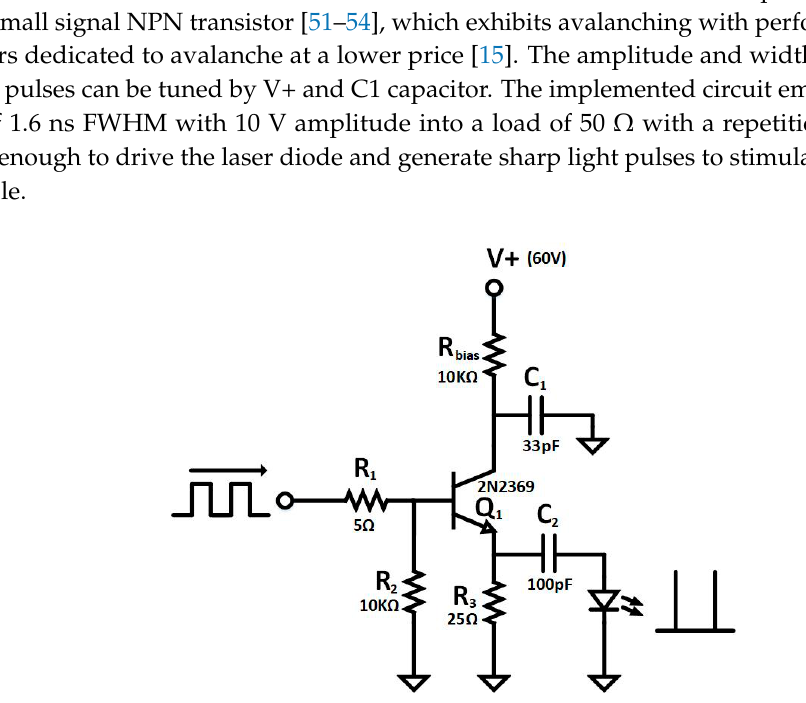
Figure 6. ( a ) Microfluidic design and final cartridge; ( b ) Microfluidic cartridge over the encapsulated chip with a detail of the microchannel over the SPAD array.